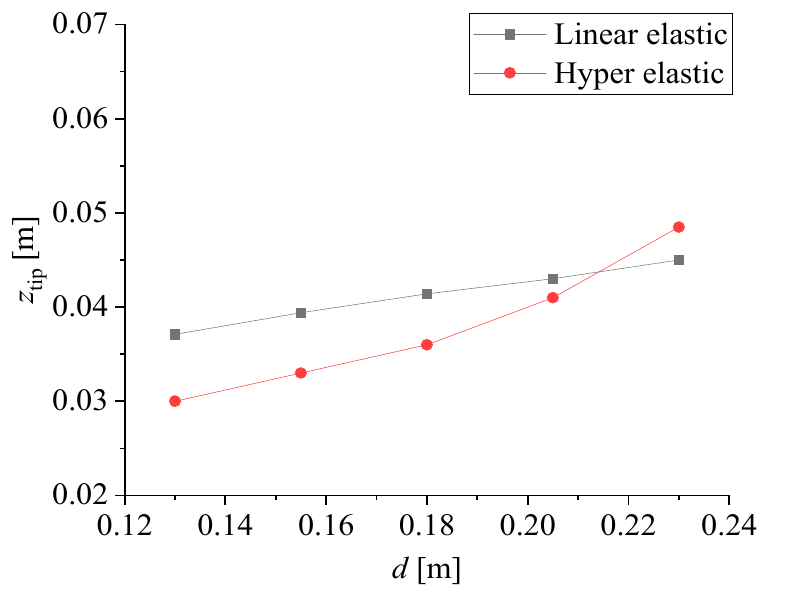
Figure 12. Tip displacement with different d values for linear-elastic and hyper-elastic materials.